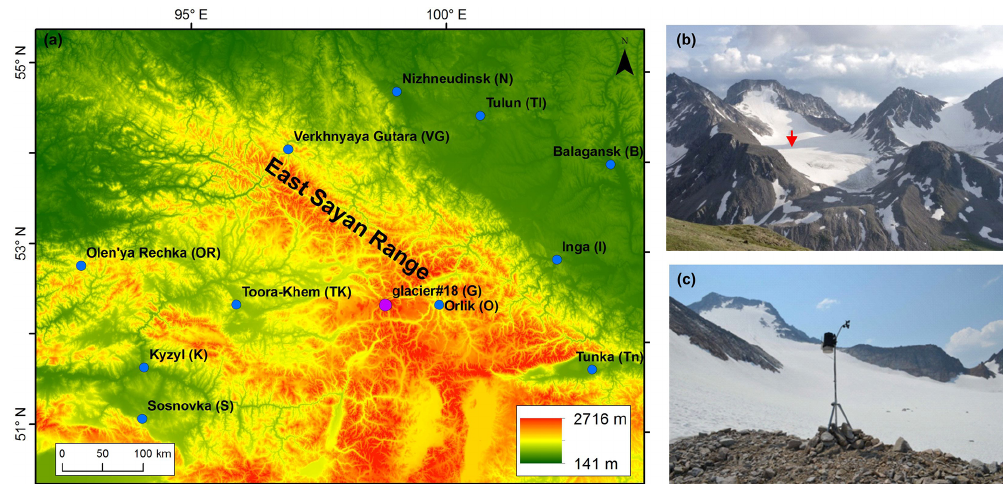
Figure 1. Location of the Glacier #18 (purple circle) and 11 regional weather stations (blue circles) in the East Sayan Range area (a) . Pictures of the glacier (b) and installed automatic weather station (AWS) (c) . Red arrow (b) shows the AWS site